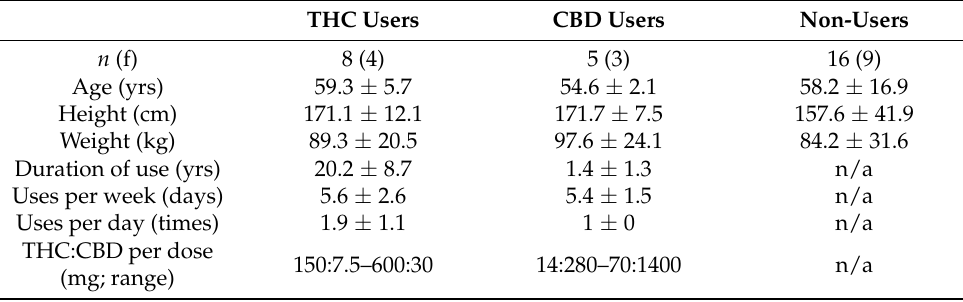
Table 1. Subject characteristics for each group. Data are mean ± SD. THC Users CBD